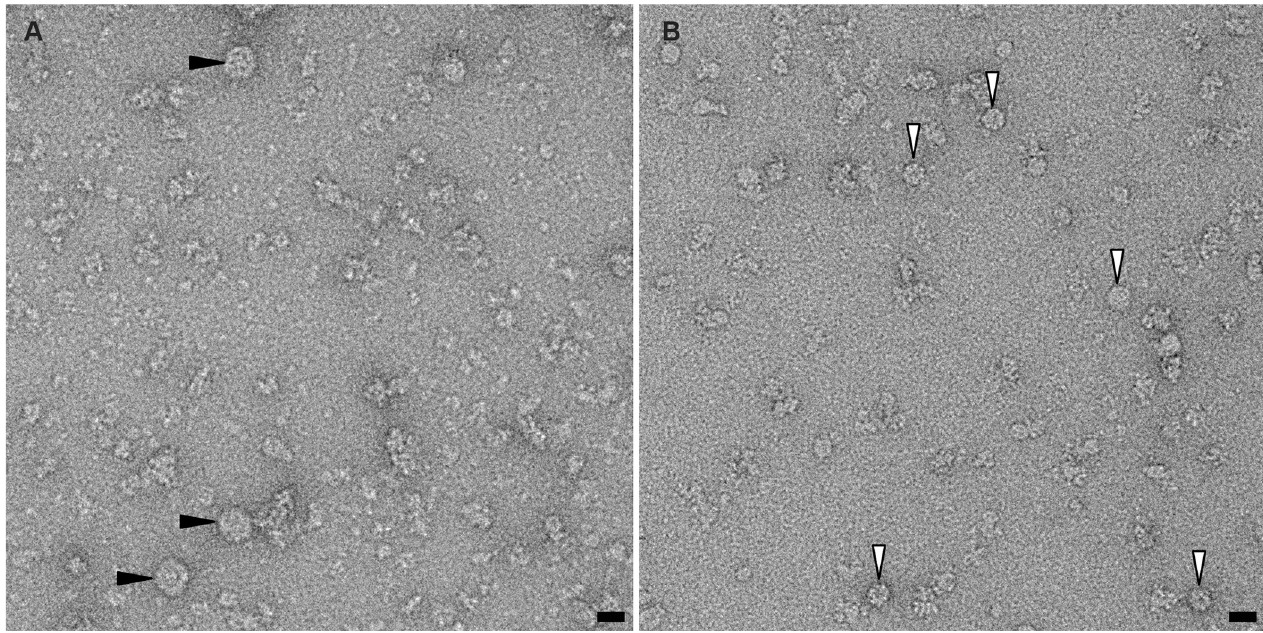
Fig 6. Negative-stain electron-microscopy images of purified recombinant CP overexpressed in E . coli . (A) Δ N-CP construct (residues 27–172). VLPs are visible in the sample (some of them are indicated by black arrows). (B) Double mutant Δ N-D87-D88-CP. No VLPs were observed. Smaller assemblies, likely pentameric capsomeres, are visible (white arrows). Scale bars in (A) and (B): 20 nm.